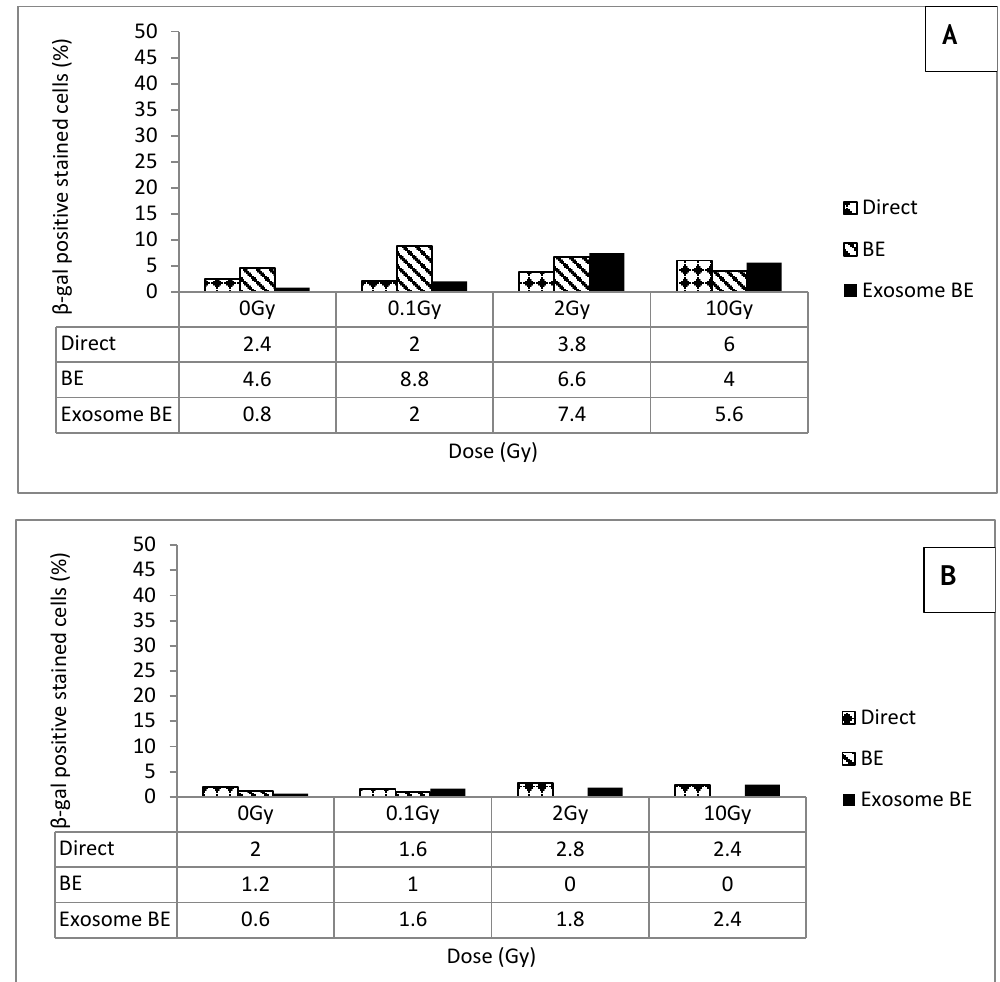
Figure 7. Percentage of senescent cells in control and irradiated FSF210316B cells at 10 passages, (30 days, panel A ) and 45 days (panel B ) following irradiation, following irradiation. Panel ( A ), the data show an increase in the level of senescent cells in the 2 Gy (a significant increase, p = 0.00001, at p < 0.05) and 10 Gy (a significant increase, p = 0, at p < 0.05) exosome bystander groups, 2 Gy (insignificant, p = 0.274) and 10 Gy (a significant increase, p = 0.0071, at p < 0.05) direct irradiated groups, and the 0.1 Gy (a significant increase, p = 0.016, at p < 0.05) media bystander group.